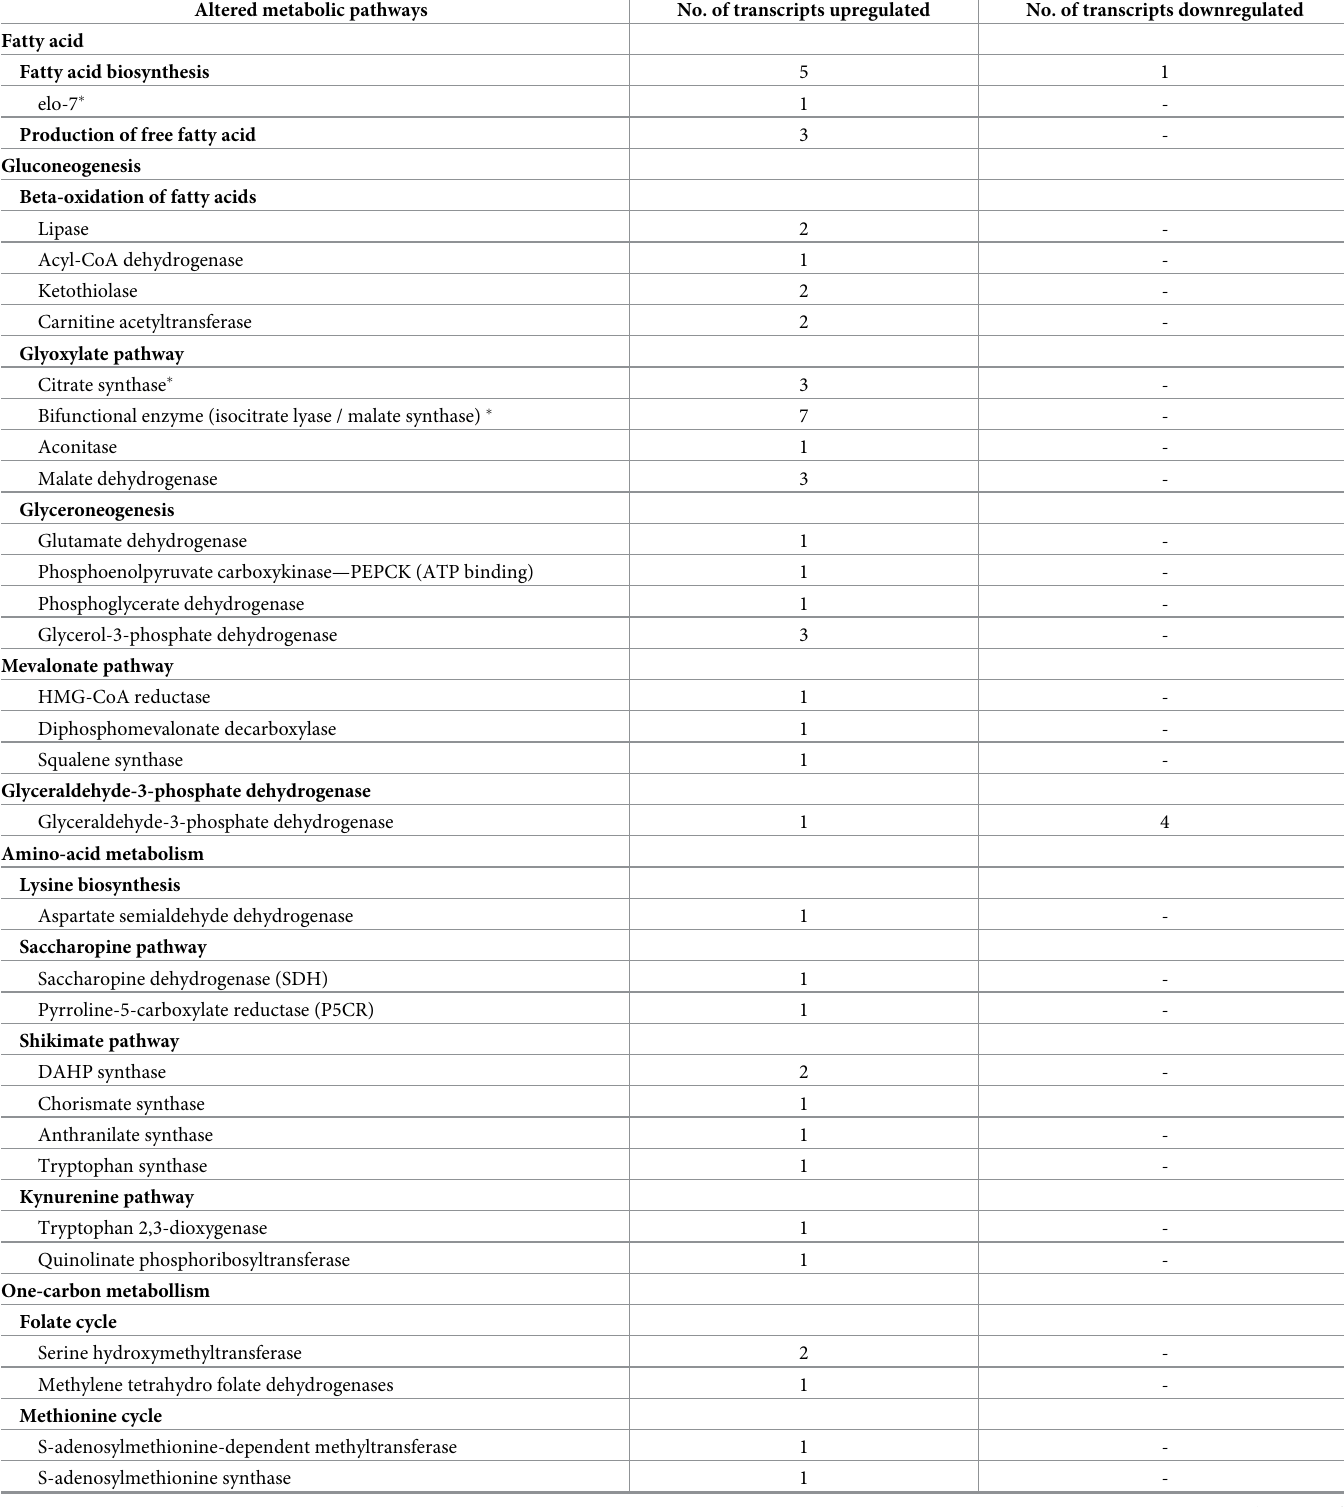
Table 3. Differentially expressed transcripts encoding key enzymes of metabolic pathways altered in anhydrobiotic H . indica